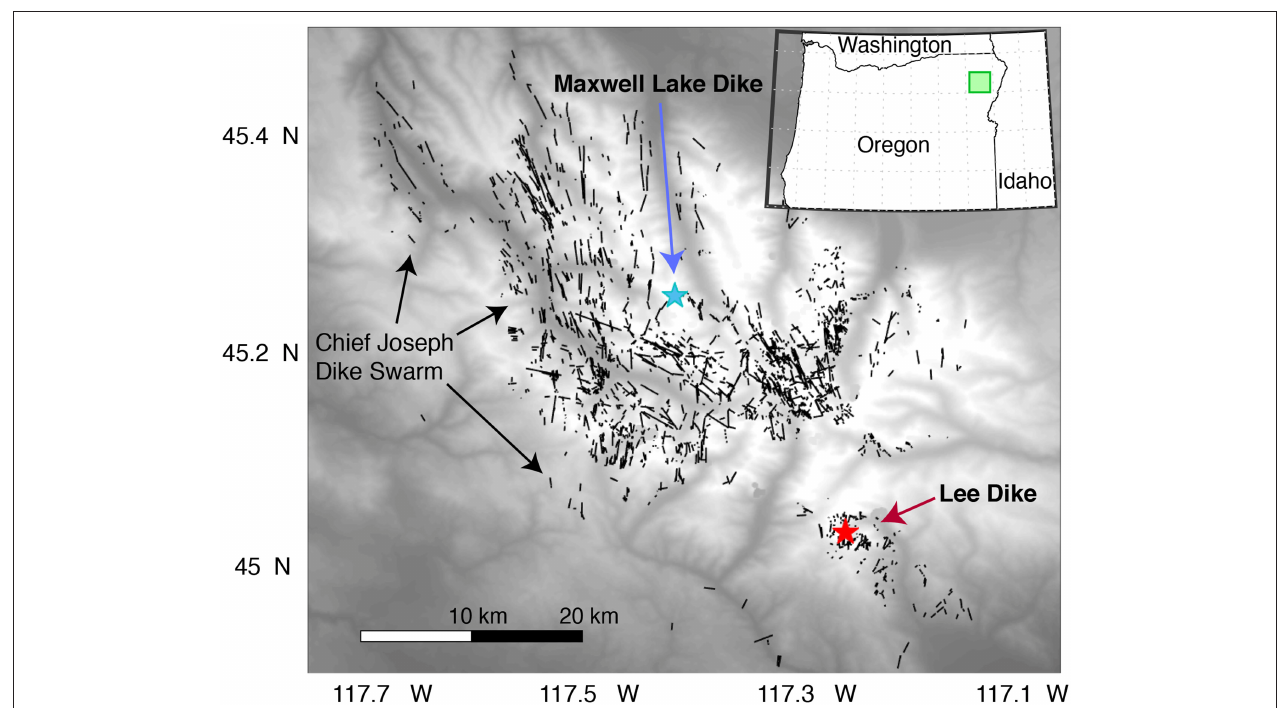
FIGURE 1 | Map showing locations of the Maxwell Lake and Lee dikes, along with distribution of Columbia River Flood Basalt Chief Joseph Dike Swarm segments (green square on inset